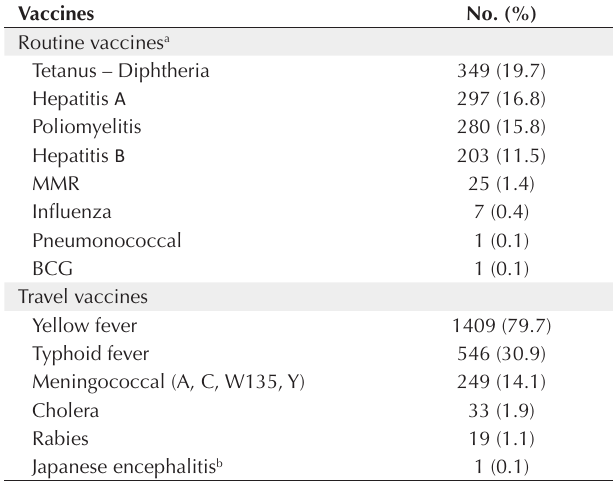
Table 2. Country Destinations to Sub-Saharan Africa Among 1768 International Travellers From Greece, 2011-2014 Country Name